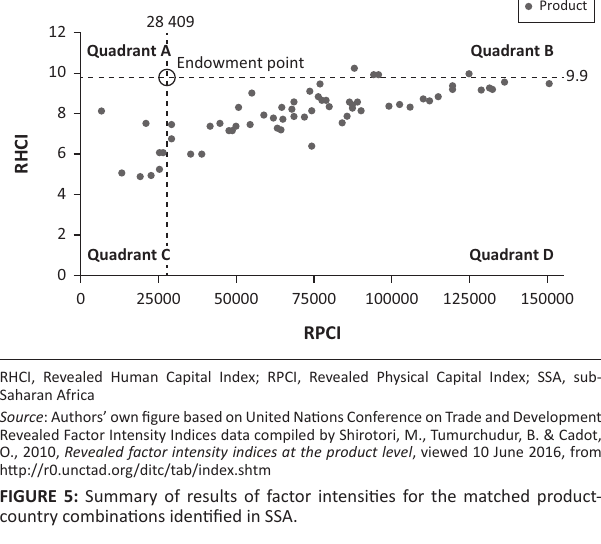
FIGURE 5: Summary of results of factor intensities for the matched product- country combinations identified in